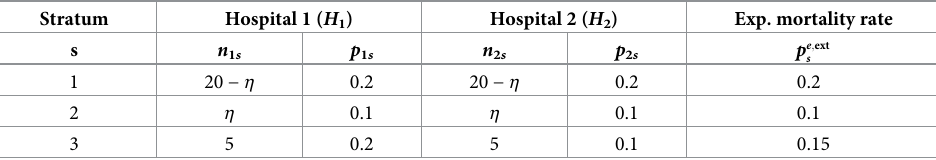
Table 1. Example of variations in case mix under external standardization: Parameter